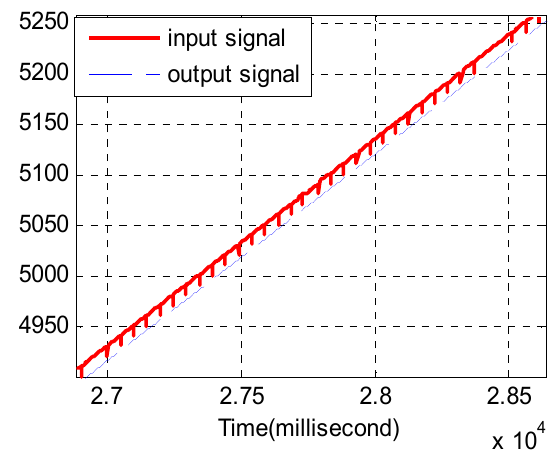
Figure 11. Comparison of the input and the output signal.